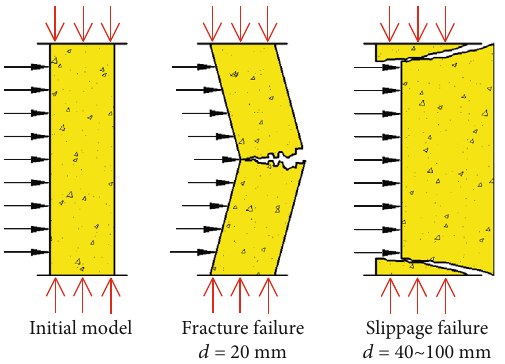
Figure 11: Failure modes of